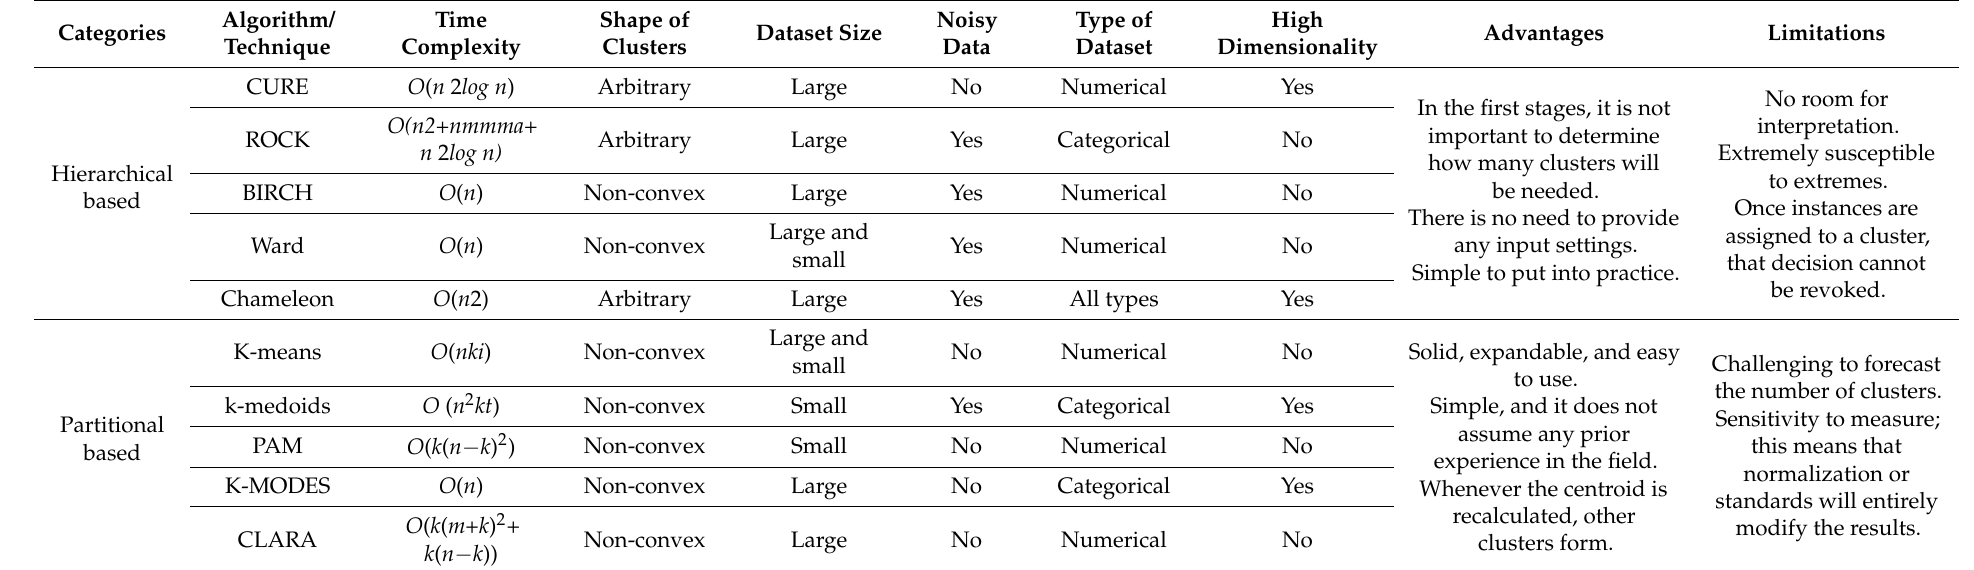
Table 1. Compression of some of partitional and hierarchical clustering